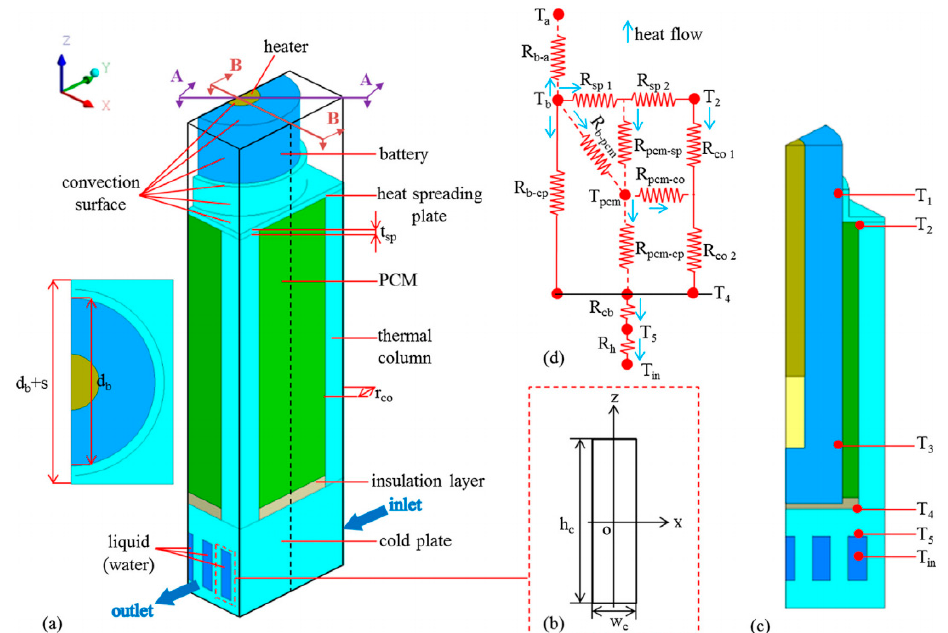
Figure 24. Schematic of a CBMS combining PCM and liquid cooling techniques. Adopted from Ref. [266]: ( a ) the numerical model of single battery; ( b ) cross section of the flow channel; ( c ) temperature monitoring points in A-A cross-section; ( d ) the simplified thermal resistance network at steady state, with dotted thermal path absent for the liquid cooling condition.